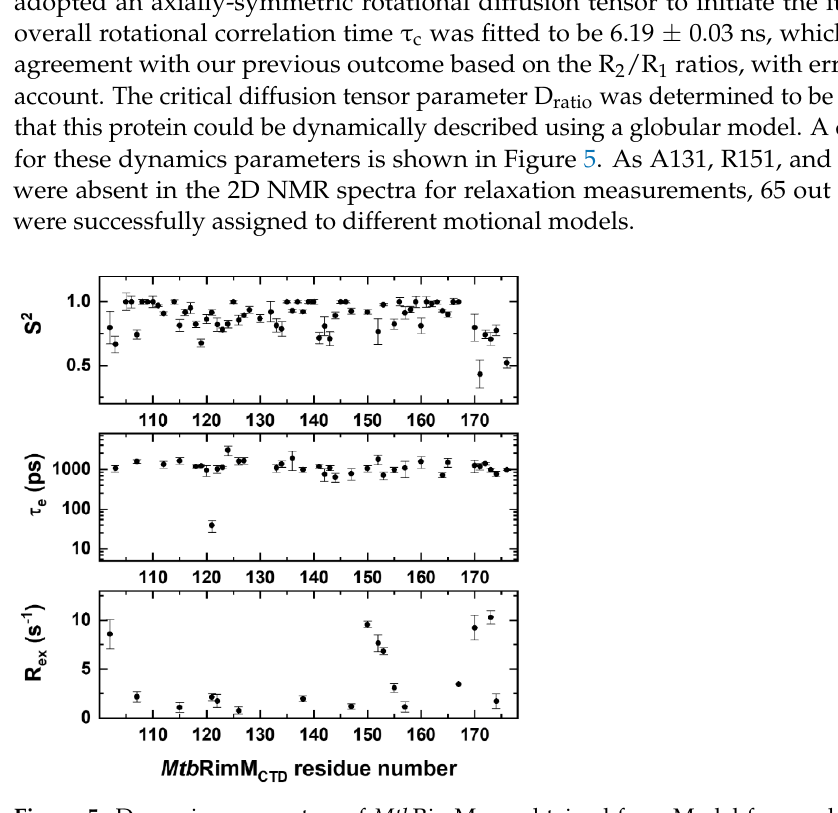
Figure 5. Dynamics parameters of Mtb RimM CTD obtained from Model-free analysis of NMR relaxation data. Residue-specific dynamics parameters S 2 ( upper panel ), τ e ( middle panel ), and R ex ( lower panel ) are plotted per residue. Residues with either lower τ e values or R ex values than their respective errors are not presented in the graphs.